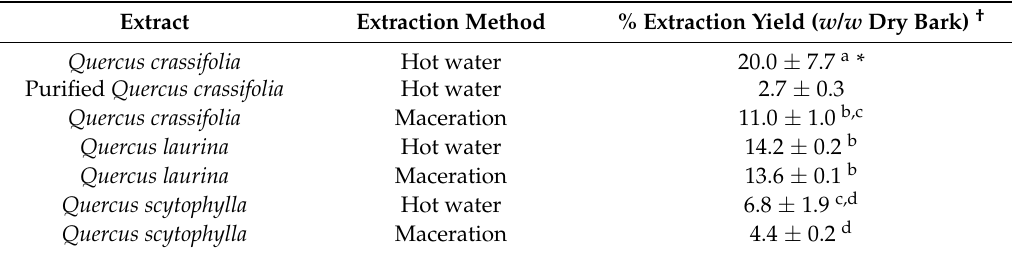
Table 1. Extraction yields of crude and purified extracts from Mexican oak species obtained by hot water and maceration methods.